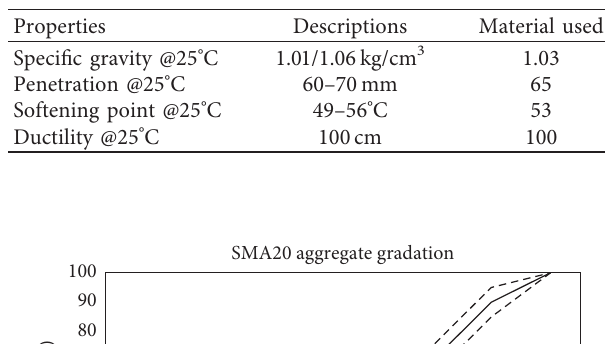
Table 2: Properties of 60/70 grade bitumen.